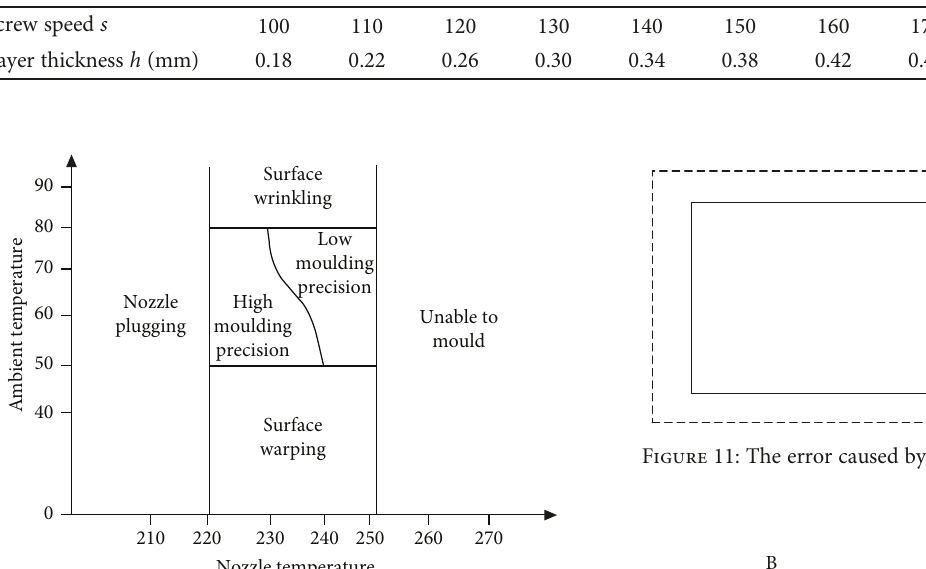
Table 5: The layer thickness measurement results of di ff erent screw speeds.